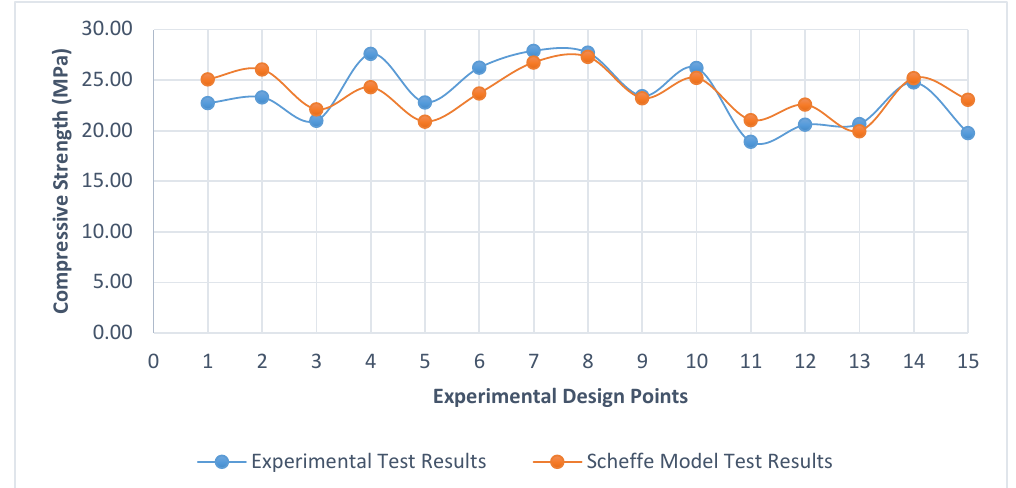
Fig. 5. The Experimental and Model Results for the Control